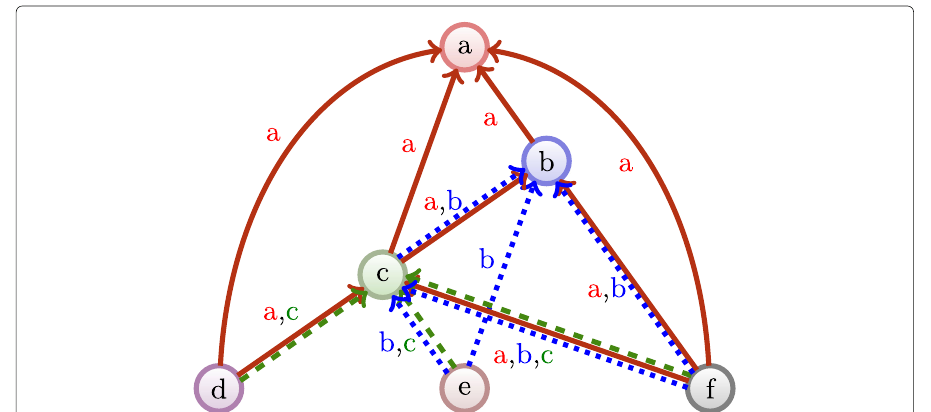
Fig. 8 Illustration of the citation network from Fig. 1 transformed to a multiplex network, each citation creates its own layer of interaction